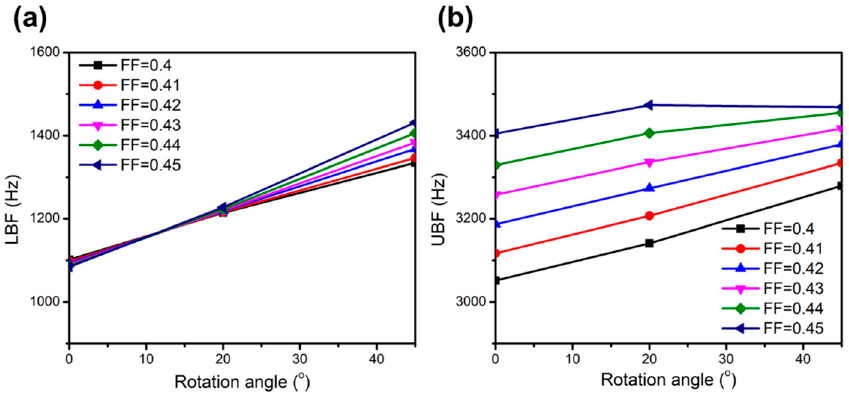
Figure A2. ( a ) Lower bound frequency (LBF) and ( b ) upper bound frequency (UBF) of the bandgap versus rotation angle in the four-square inclusion composite with different filling fractions.